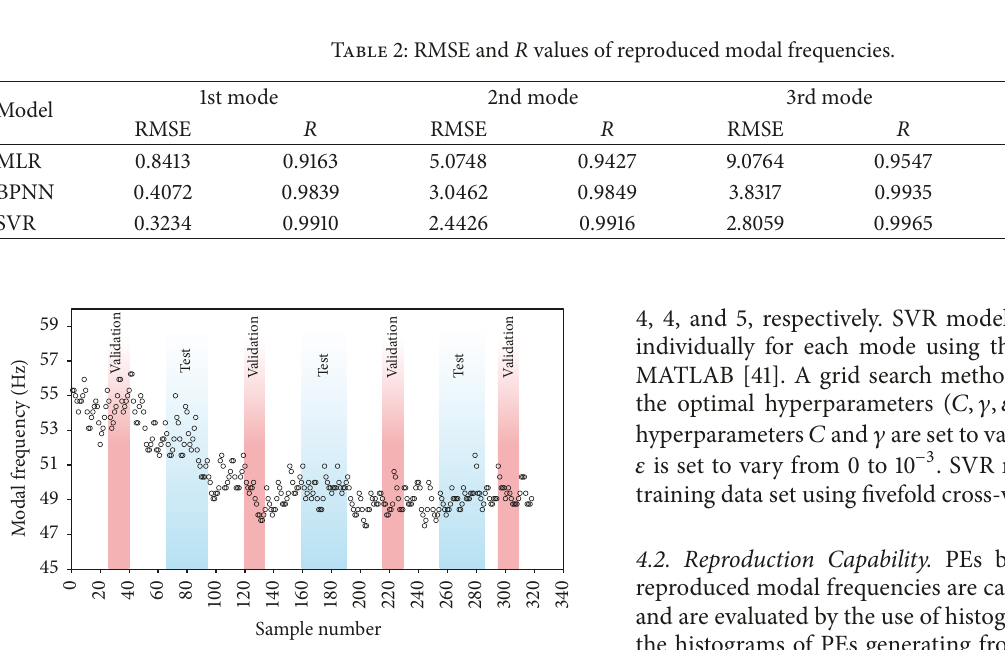
Figure 7: Sample selection for training, validation, and test